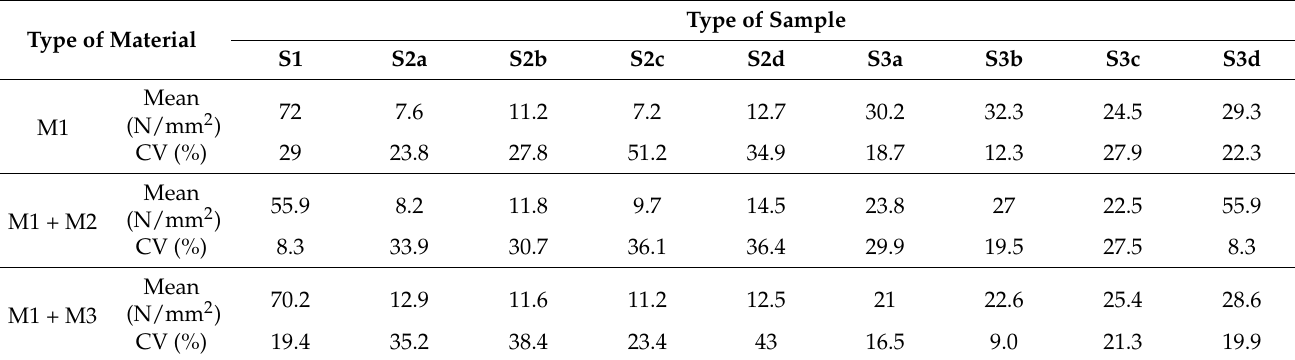
Table 1. Young’s modulus mean values and coefficient of